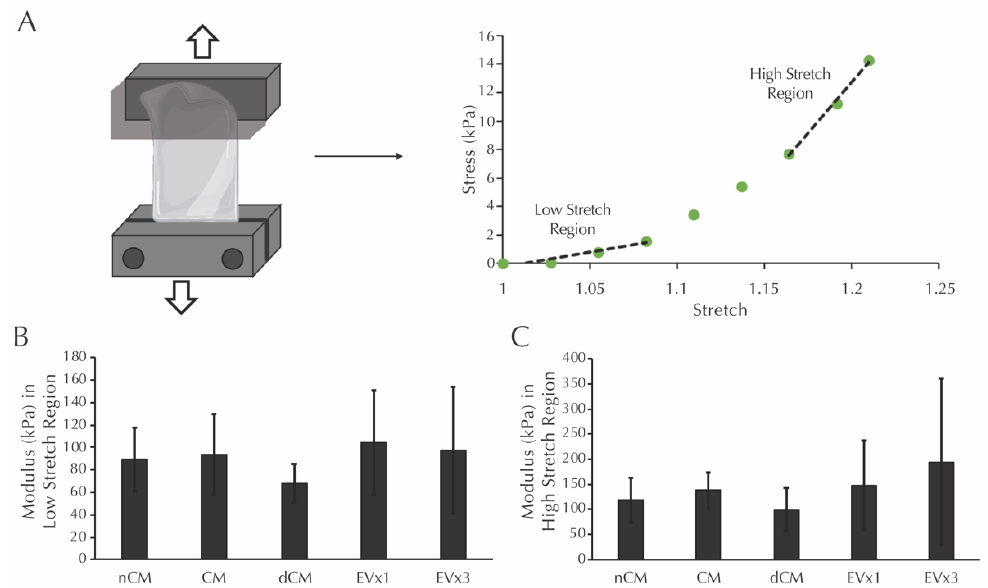
Figure 4. Moduli in the low and high stretch regions for fibrin strands are not increased after 30 days of EV-containing treatment groups. ( A ) Schematic of the mechanical testing procedure for fibrin strands and the definition of low and high stretch regions. ( B ) Modulus of the system in the low stretch region following culture with the treatments described in Figure 2. ( C ) Modulus of the system in the high stretch region following culture with the same treatments. No significant differences were detected using one-way ANOVA.